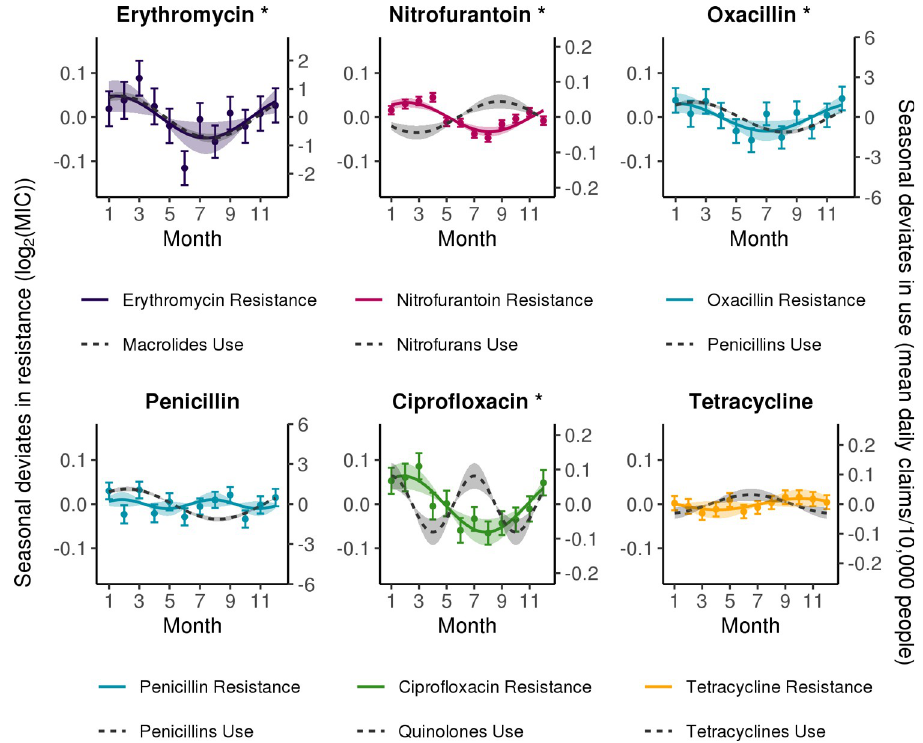
Fig 2. Seasonality of antibiotic use and resistance by class in Staphylococcus aureus . Solid lines indicate point estimates of the amplitude and phase from the best-fitting sinusoidal model of resistance (comparing 6- and 12-month periods) to each antibiotic, colored by class. Dashed gray lines indicate point estimates of the amplitude and phase of sinusoidal models for use of the corresponding antibiotic class. Shaded regions indicate the 95% CIs for the amplitude. Points indicate the monthly mean seasonal deviates in resistance, and error bars indicate the standard error of the mean. Asterisks indicate the amplitude of seasonality in resistance is statistically significant (FDR < 0.05). FDR, false discovery rate; MIC, minimum inhibitory concentration. Underlying data are available at https://github.com/gradlab/ use-resistance-seasonality/tree/master/figure_data/Fig2